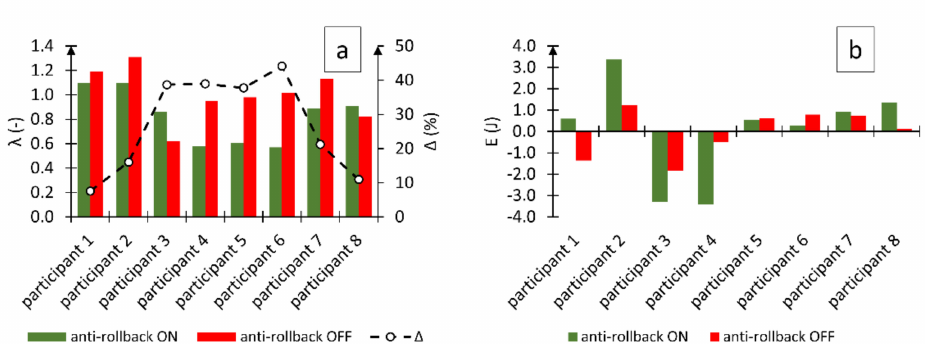
Figure 10. The diagrams of ( a ) the average coe ffi cient of the generated power and loss power ratio in a single propelling cycle and ( b ) the total mechanical energy of a single propelling cycle for respective participants with the activated anti-rollback system (anti-rollback ON) and the deactivated anti-rollback system (anti-rollback system OFF). Where: ∆ —a percentage di ff erence between the parameter measured with the activated anti-rollback-system and with the deactivated